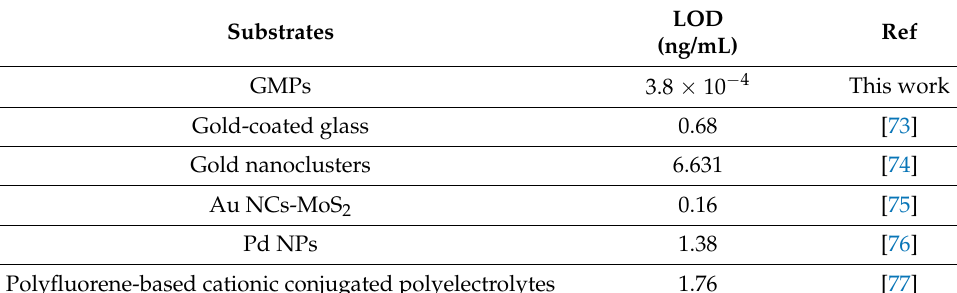
Table 3. Other works in AFP detection based on